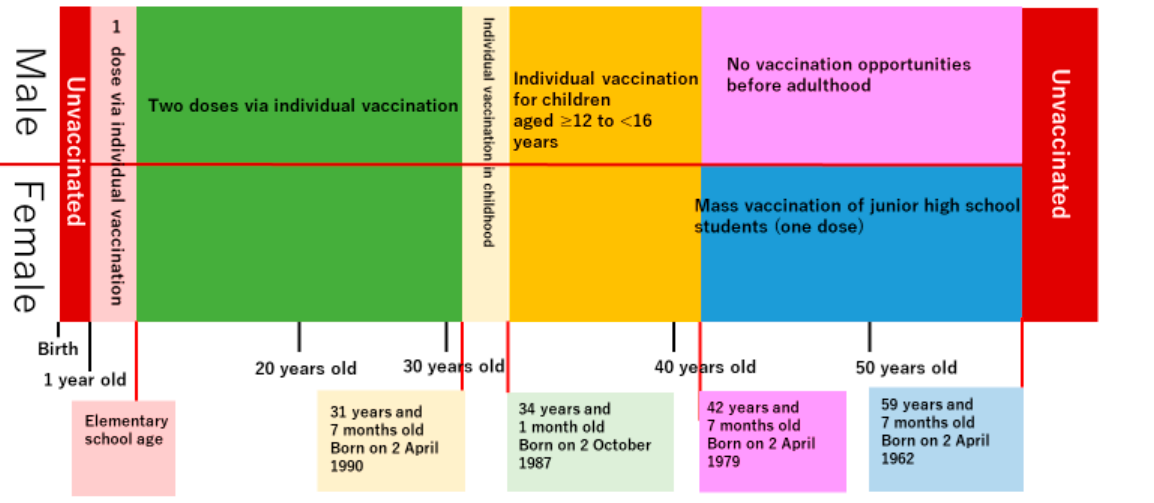
Figure 1. Association between the routine vaccination program with rubella-containing vaccines and age (as of 1 November 2021).